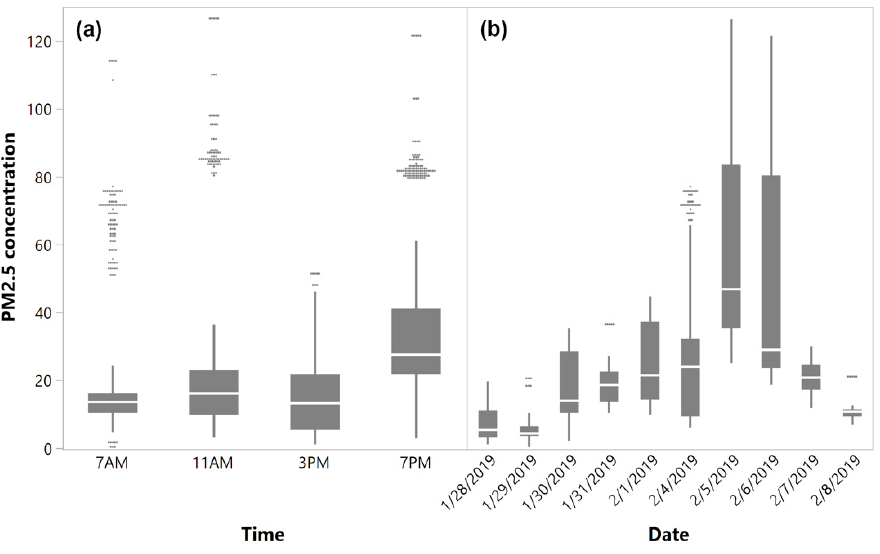
Figure 6. Box plots showing ( a ) the diurnal variation and ( b ) daily variation of PM 2.5 concentrations (µg/m 3 ).